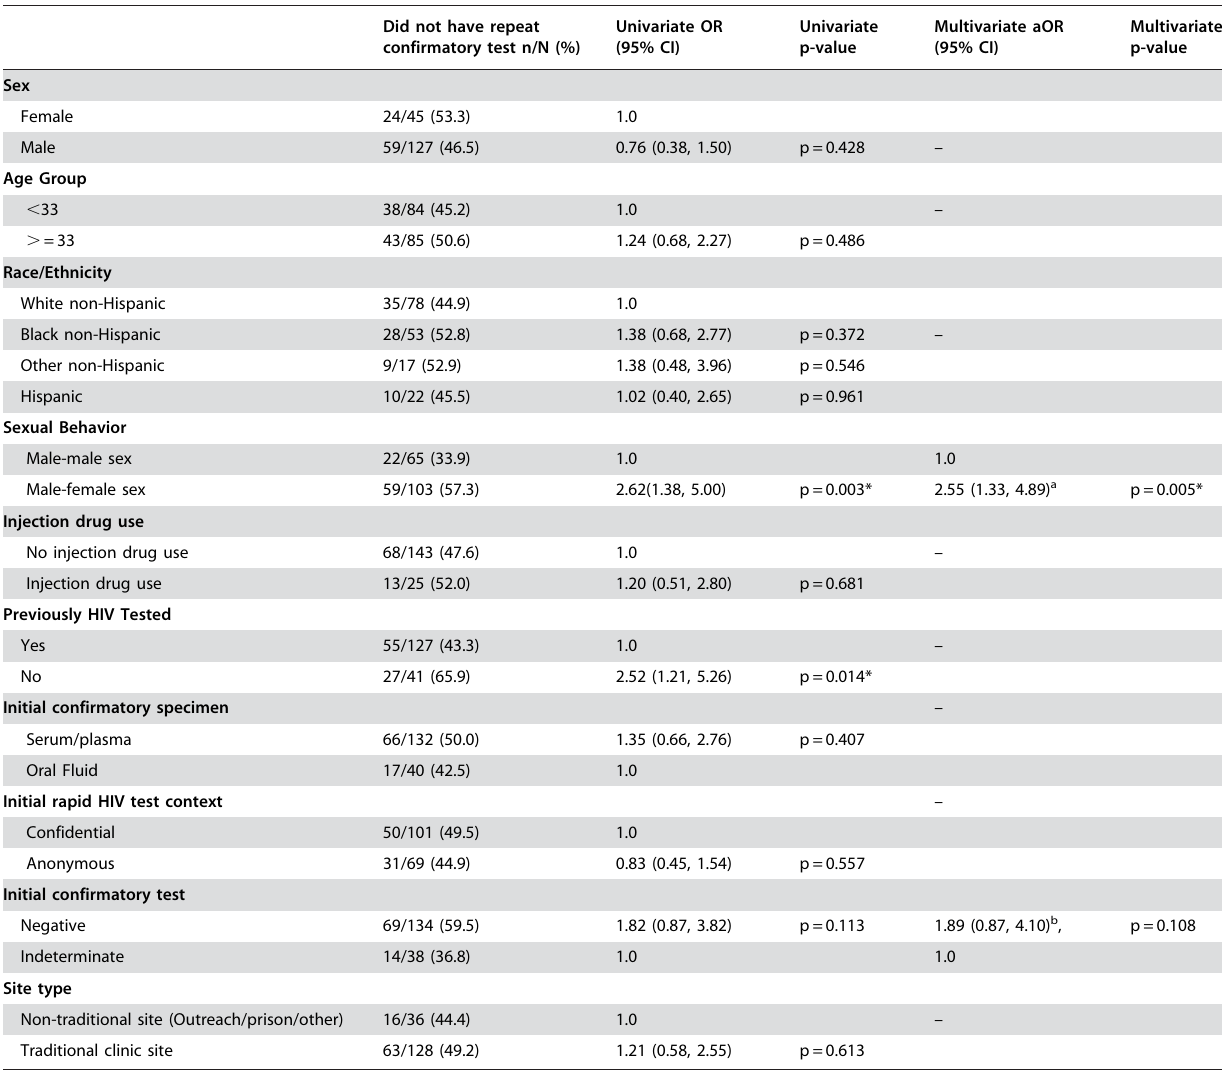
Table 3. Demographic, risk, and initial test characteristics of 172 persons with reactive rapid HIV test result and negative